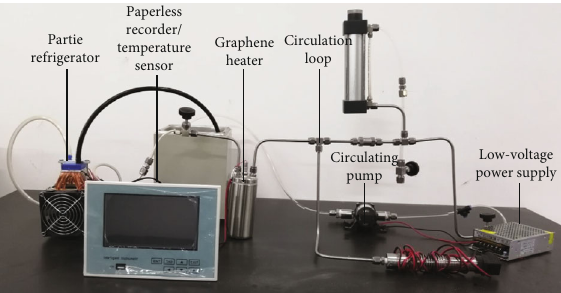
Figure 8: Setting up the experimental platform of the insulation